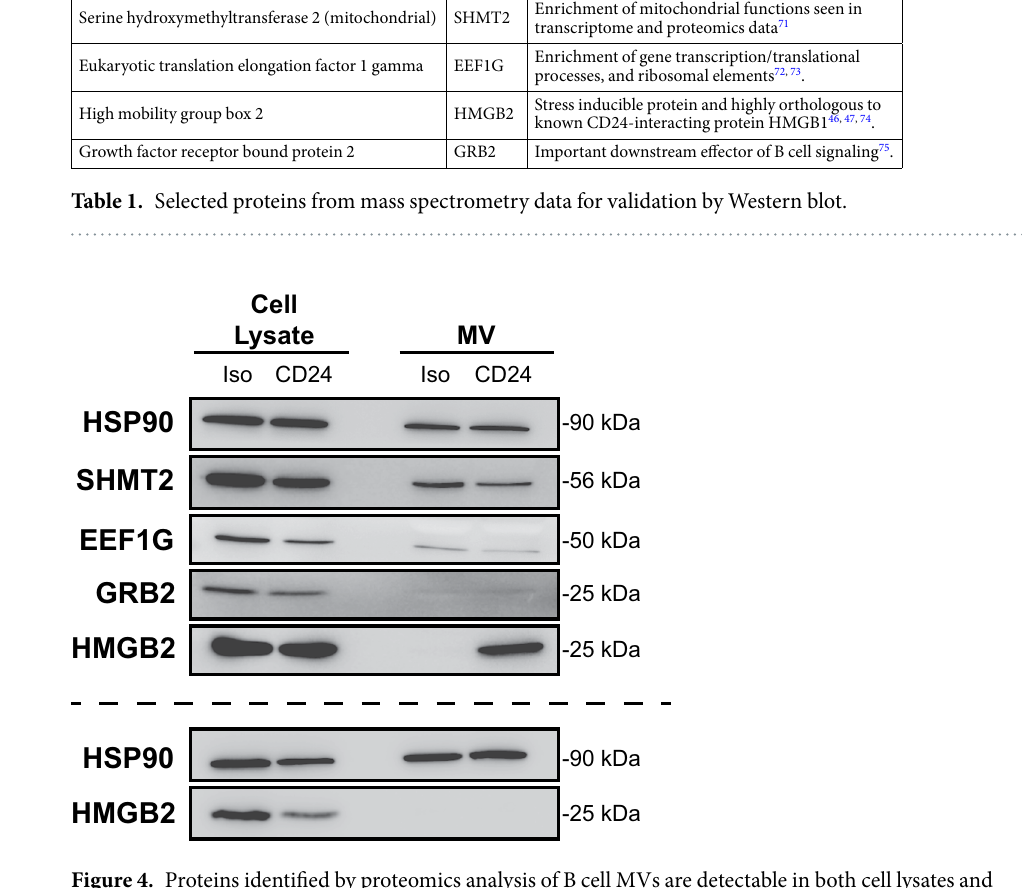
Figure 4. Proteins identified by proteomics analysis of B cell MVs are detectable in both cell lysates and MVs of isotype and anti-CD24 stimulated B cells by Western blot analysis. Cell lysates (5 µ g; equivalent to approximately 2.3 × 10 5 cells) and the corresponding protein from MVs (from 1.0 × 10 6 cells) were analyzed for expression of SHMT2, EEF1G, GRB2 and HMGB2. HSP90 was used as a loading control after stimulation with isotype (Iso) or anti-CD24 (CD24). n = 5. Two different outcomes were observed for HMGB2, with MVs from CD24 stimulated cells containing high HMGB2 (Upper panels, n = 2) or HMGB2 being low/absent in all vesicles (lower panels n =